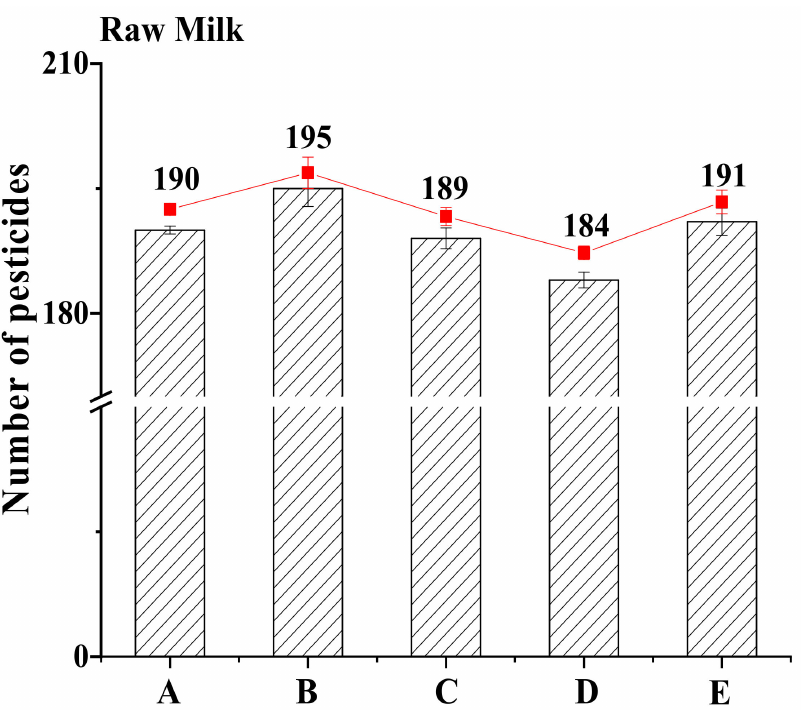
Figure 3. Comparison of different sorbents for dispersive-SPE clean-up of analytes in raw milk. ( A ): 100 mg C18; ( B ): 200 mg C18; ( C ): 300 mg C18; ( D ): 50 mg PSA; and ( E ): 50 mg PSA+ 200 mg C18.